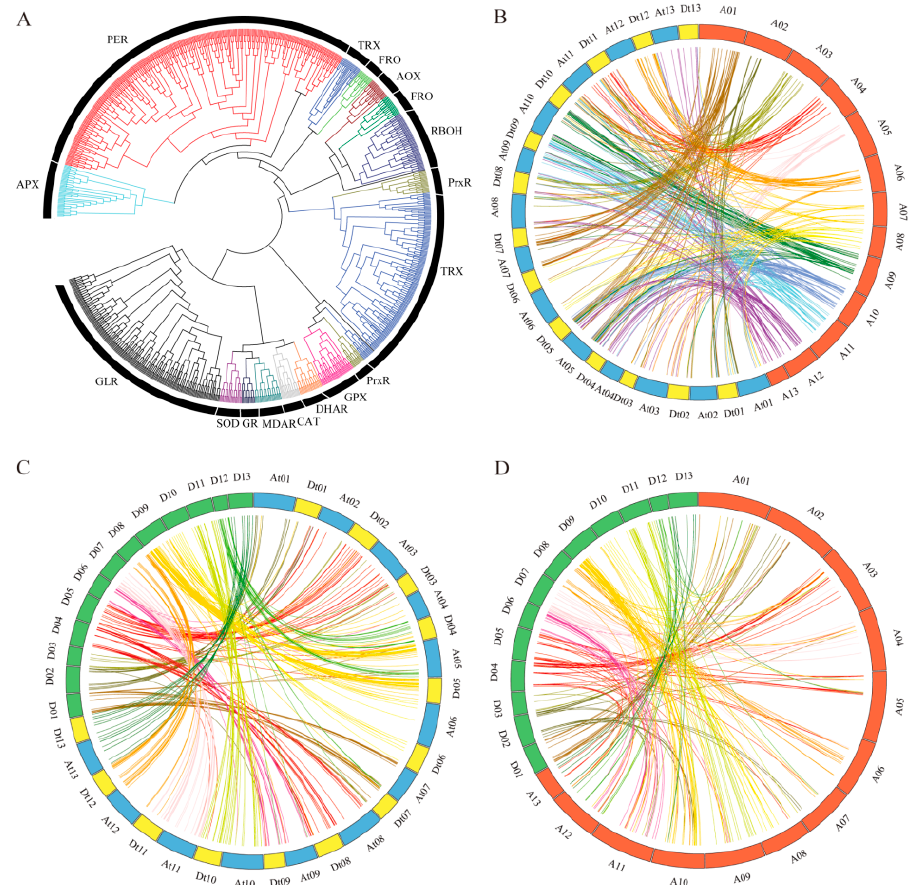
Figure 2. Phylogenetic tree and synteny analysis. ( A ) Phylogenetic tress analysis of all the cotton ROS network genes in G. hirsutum, G. raimondii, and G. arboreum. ( B ) Synteny analysis between A genome and allotetraploid AD 1 genome. ( C ) Synteny analysis between D genome and allotetraploid AD 1 genome. ( D ) Synteny analysis between A and D genomes. Red, green, yellow, and blue block means A genome, D genome, Allotetraploid cotton (TM-1) A and D subgenomes, respectively. The lines with different color mean genes of different chromosome (A and D genomes).